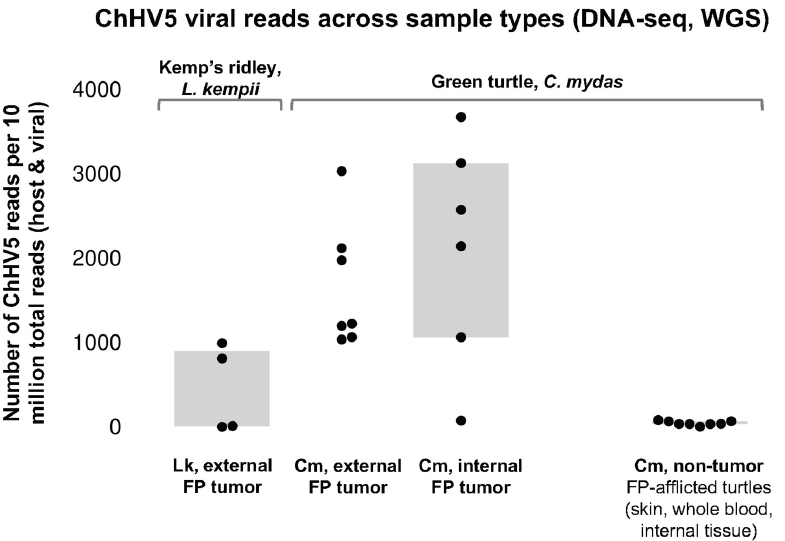
Figure 6. Chelonid alphaherpesvirus 5 (ChHV5) viral reads across sample types based on results of whole-genome sequencing (DNAseq). Comparing tumor ChHV5 loads (reads per ten million) shows significantly lower viral loads in samples from Kemp’s ridley sea turtles ( Lepidochelys kempii ) versus those typically observed in green sea turtles ( Chelonia mydas ; green turtle ChHV5 data adapted from Farrell et al. [14]). Abbreviations: ChHV5, chelonid alphaherpesvirus 5; Cm, C. mydas ; FP, fibropapillomatosis; Lk, L. kempii ; WGS, whole genome sequencing.